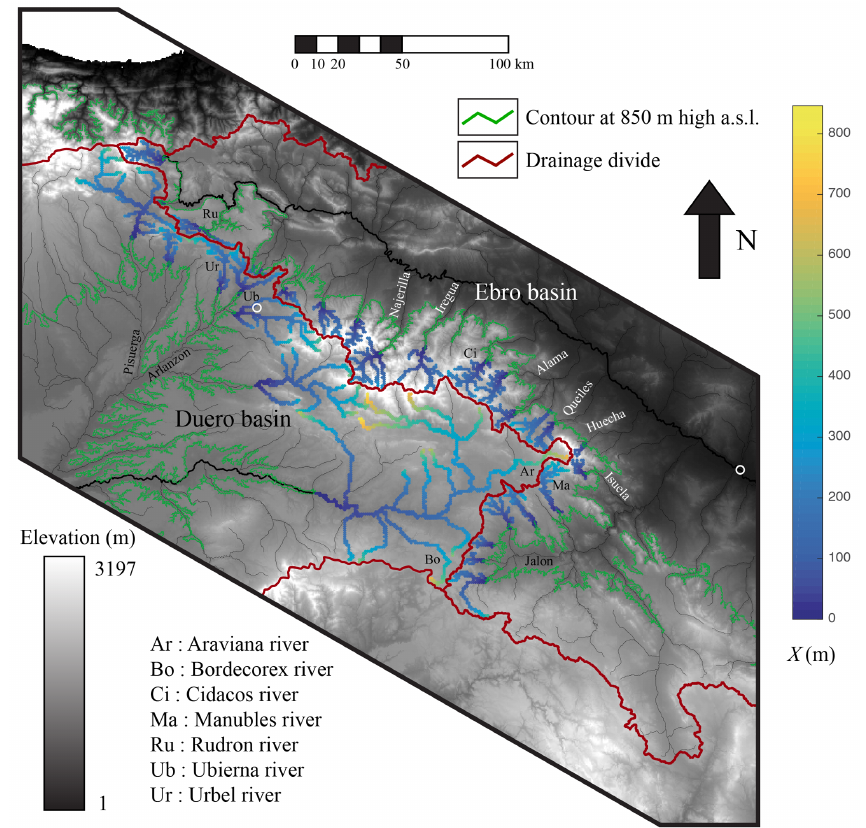
Figure 11. Topographic map with χ values calculated on different opposite streams in the vicinity of the Ebro–Duero drainage divide. This map shows significant contrasting values between the Ebro and Duero drainage